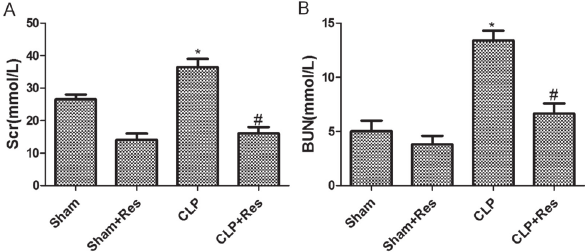
Fig. 2. Effects of resveratrol on (A) serum creatinine and (B) urea nitrogen levels of septic rats. *Compared with Sham group, P <0.05; #compared with CLP group, P